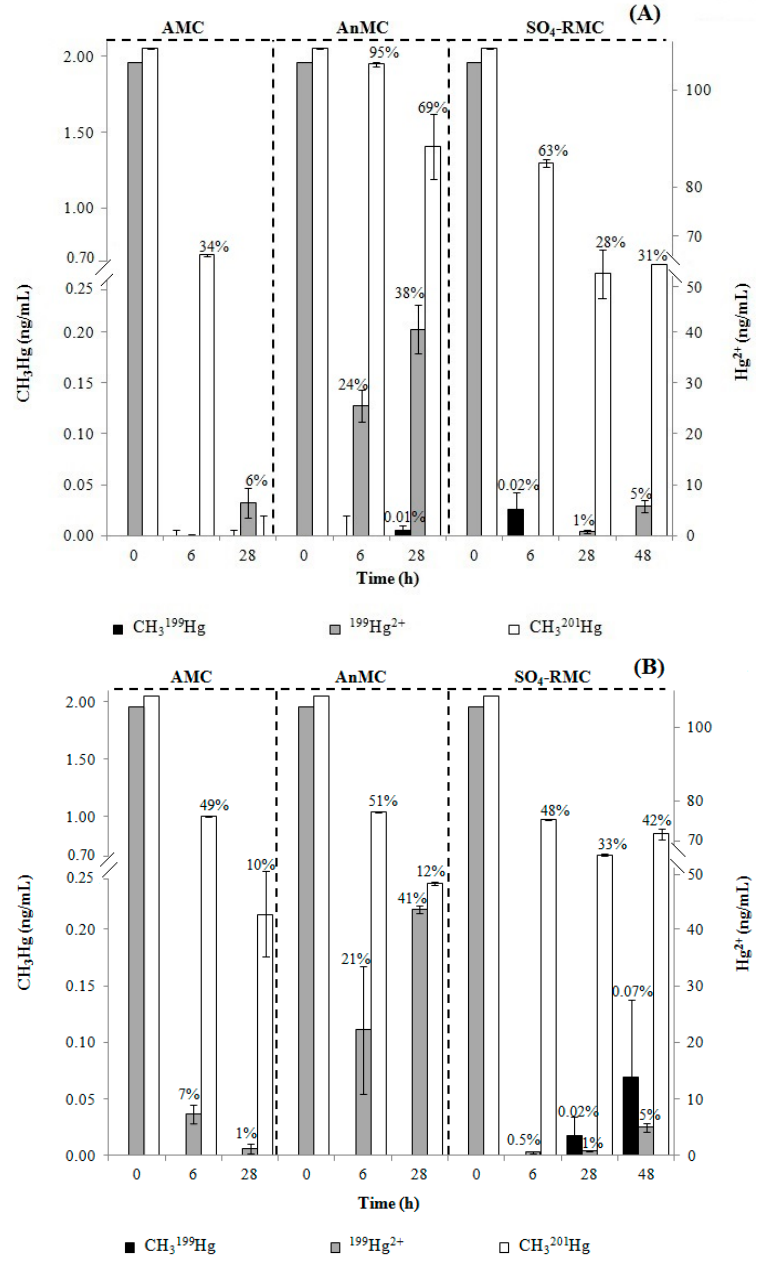
Figure 3. Representation of isotope concentrations in the supernatant of media containing different microbial communities. The results show the formation of CH 3199 Hg from the initial 105.6 ng/mL 199 Hg 2+ added and the decrease of the initial 2.05 ng/mL of CH 3201 Hg with incubation time (6, 28, and 48 h). Three different microbial communities, an aerobic microbial community (AMC), anaerobic microbial community (AnMC), and sulphate-reducing microbial community (SO 4 -RMC), were isolated from two mercury-contaminated areas of the Tagus estuary—Cala do Norte ( A ) and Barreiro ( B